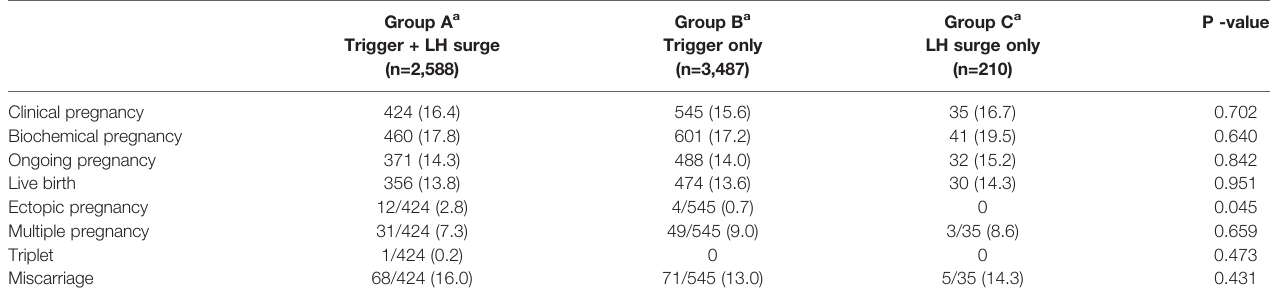
TABLE 3 | The pregnancy outcomes of patients undergoing IUI.